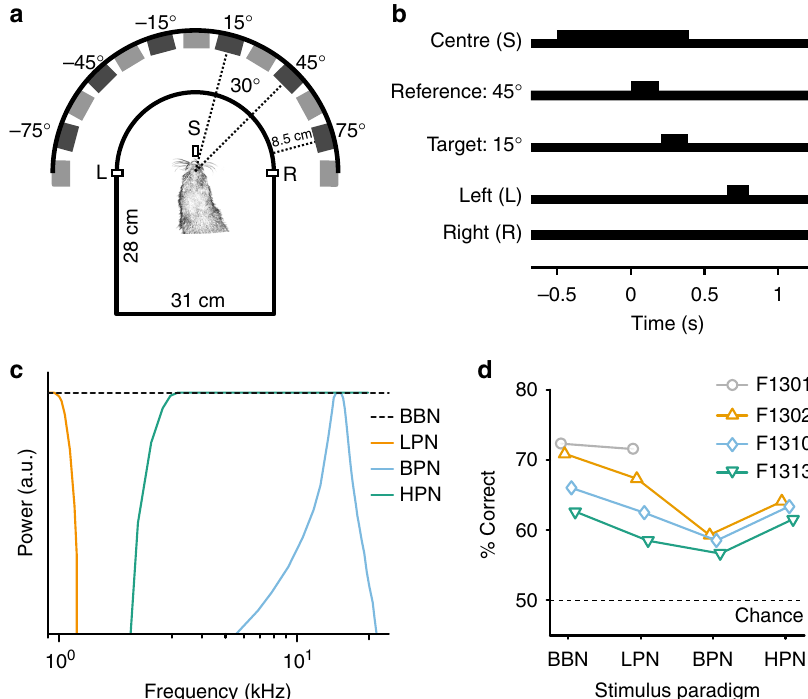
Fig. 1 Relative localisation behaviour and performance. a Ferrets were trained to report the location of a target sound relative to a preceding reference, with target and reference sounds originating from two speakers separated by 30° (main speaker locations indicated). Ferrets reported the relative location of the target at a left (L) or right (R) response spout (positioned at ± 90°). b Ferrets were required to maintain contact with the central start spout (S) for a pre-stimulus hold time (500 – 1500 ms) before the reference sound (150 ms, shown here at 45°) was presented and remain there until at least halfway through the target sound (150 ms, here at 15°) before responding. c Schematic showing the spectrum of each of the stimulus paradigms. d Mean performance across all trials of ferrets in four different conditions, in which the stimuli were broadband noise (BBN), low-pass fi ltered noise (<1 kHz, LPN), bandpass fi ltered noise (1/6 octave about 15 kHz, BPN) and high-pass fi ltered noise (>3 kHz, HPN). All animals performed the task above chance in each condition (binomial test, p < 0.001)